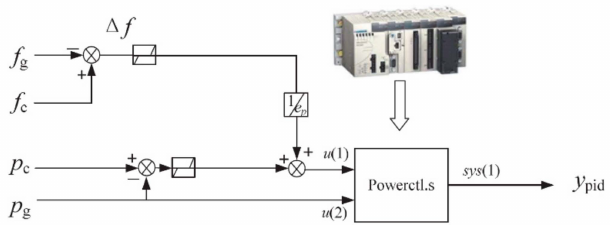
Figure 30. Simulation model of a governor in a power regulation mode in an HTGS [48].